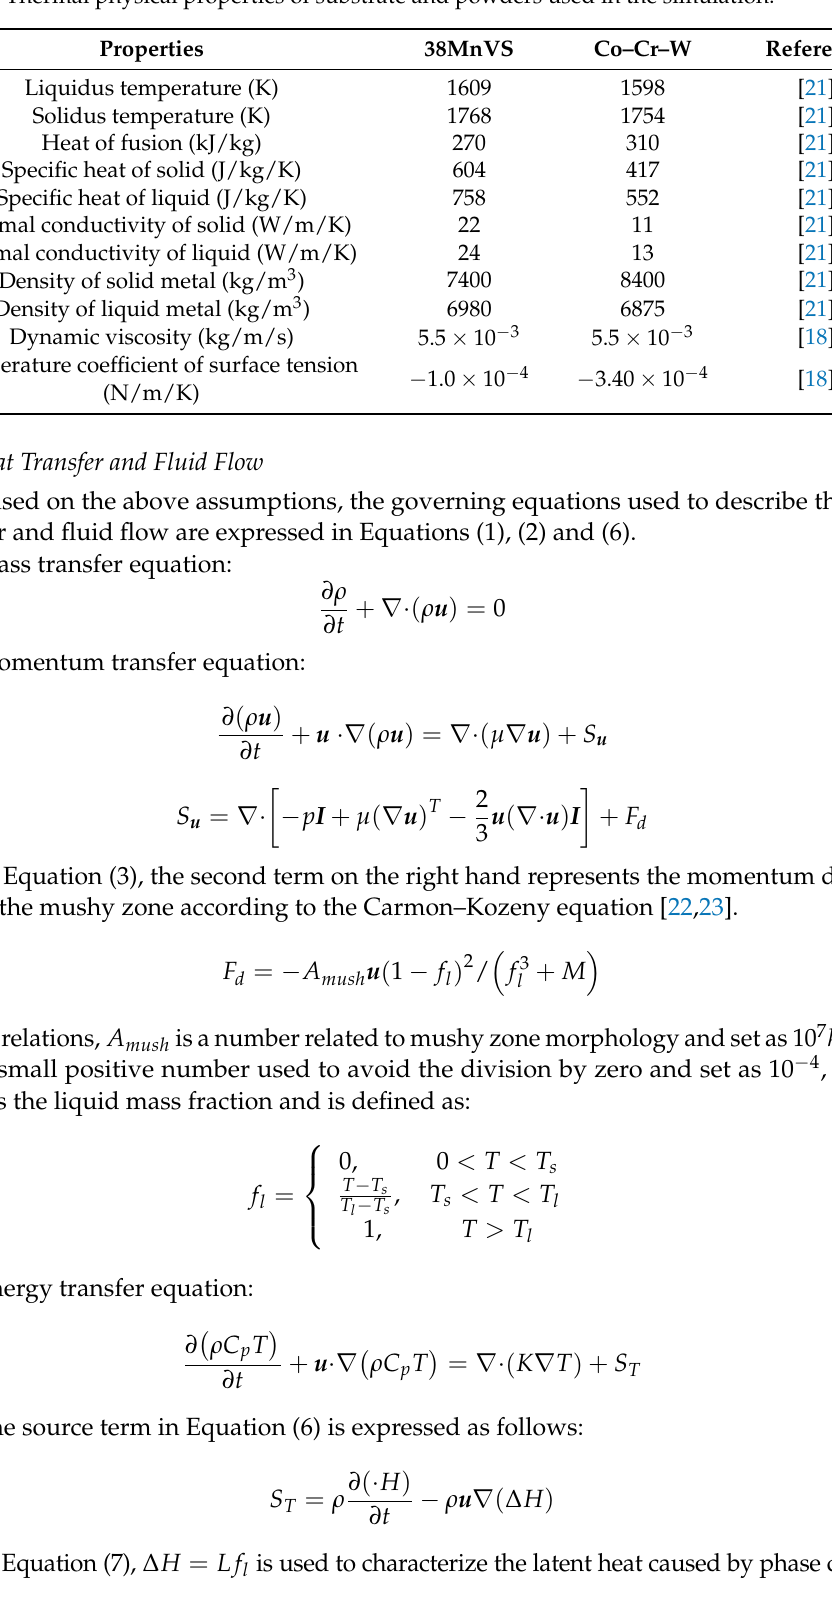
Table 2. Thermal physical properties of substrate and powders used in the